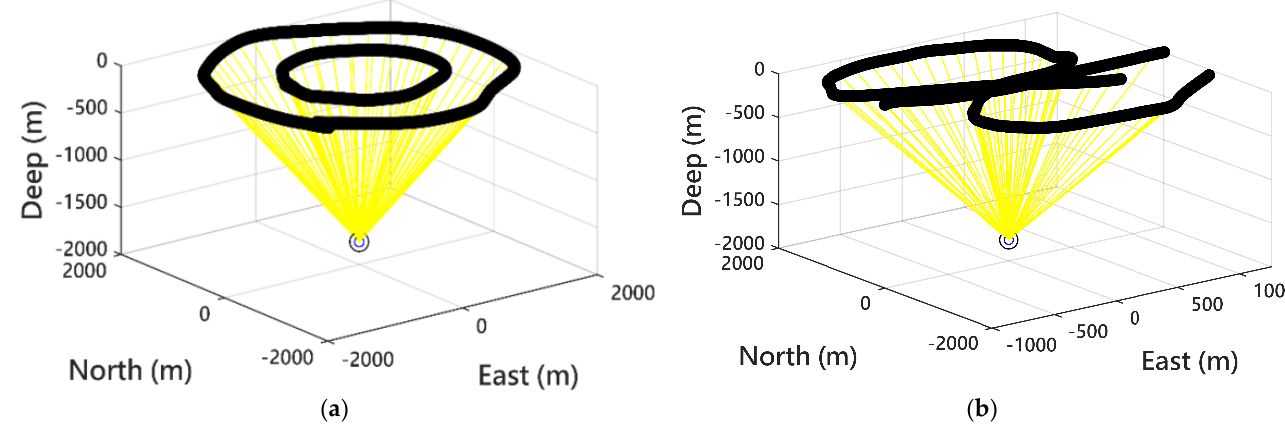
Figure 7. Two circles around the seafloor transponder with R = 2000 and R = 1000 ( a ). A crossing along the diameter directly above the transponder and a figure eight with the seafloor transponder in the center with R = 1000 ( b ). Table 1. The information of acoustic